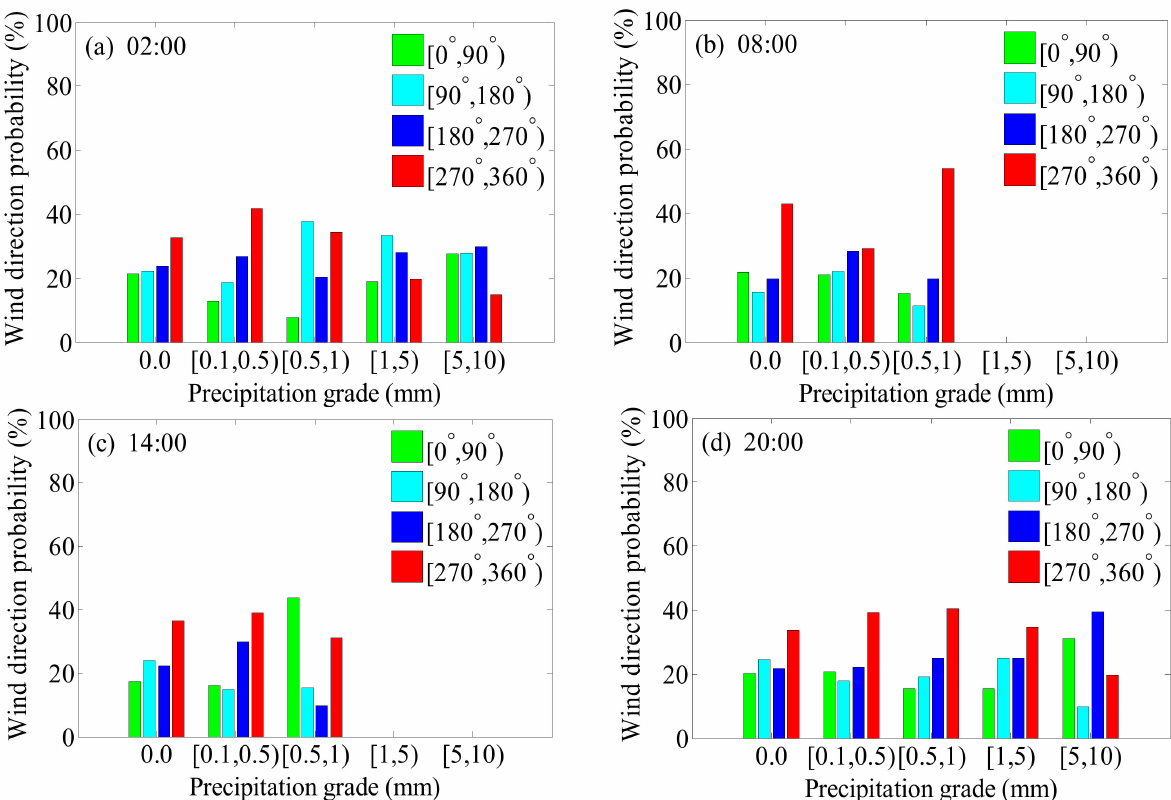
Figure 7. Atmospheric horizontal wind direction probability below 3 km in different precipitation grades at launch times in Jiulong from 2013–2020. ( a ) 02 LST, ( b ) 08 LST, ( c ) 14 LST and ( d ) 20